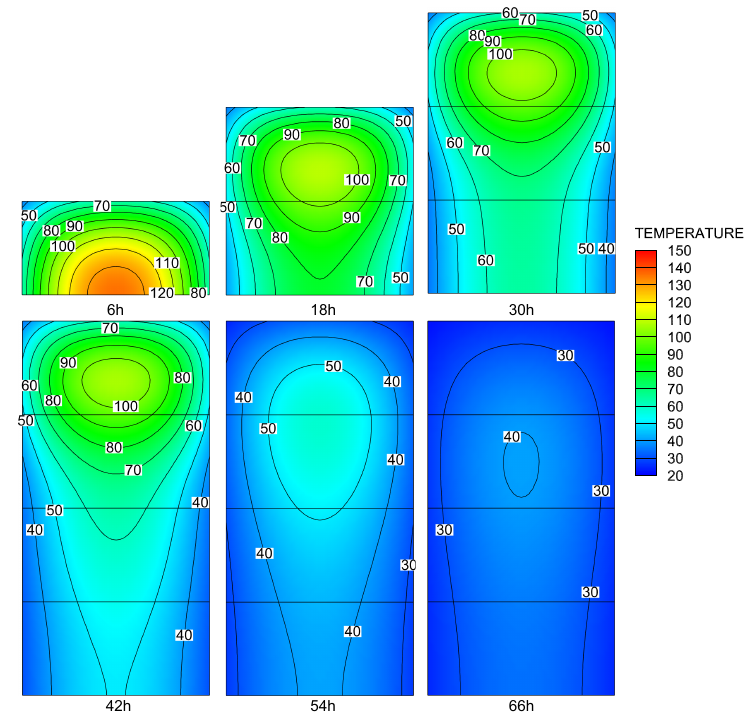
Figure 6. The temperature contour of Example 2 (FEM).